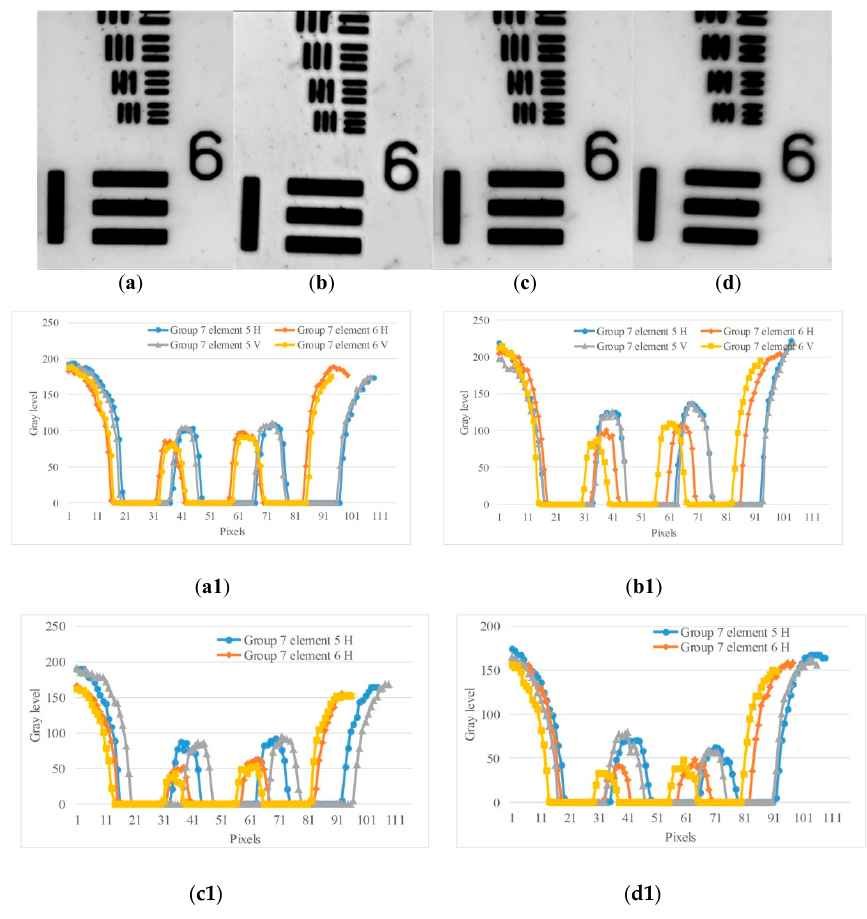
Figure 6. Imaging results obtained using the 1951USAF resolution target with di ff erent wavelength light sources. ( a ) Image at λ = 480 nm; ( b ) image at λ = 550 nm; ( c ) image at λ = 660 nm; ( d ) image at λ = 850 nm. ( a1 )–( d1 ) are the horizontal and vertical intensity profiles of the four images in group 7 element 5 and group 7 element 6,